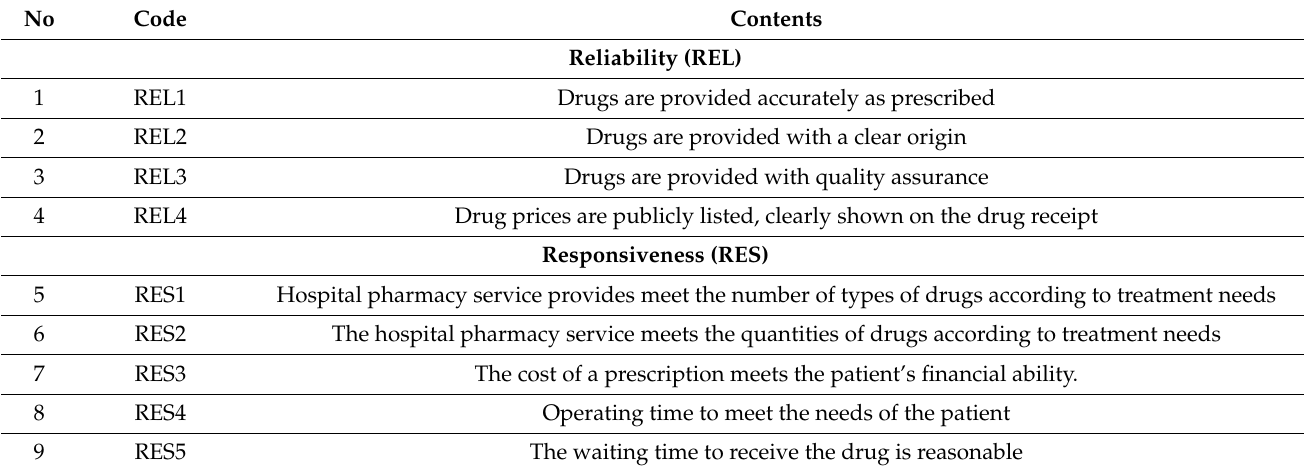
Table 1. The contents of the